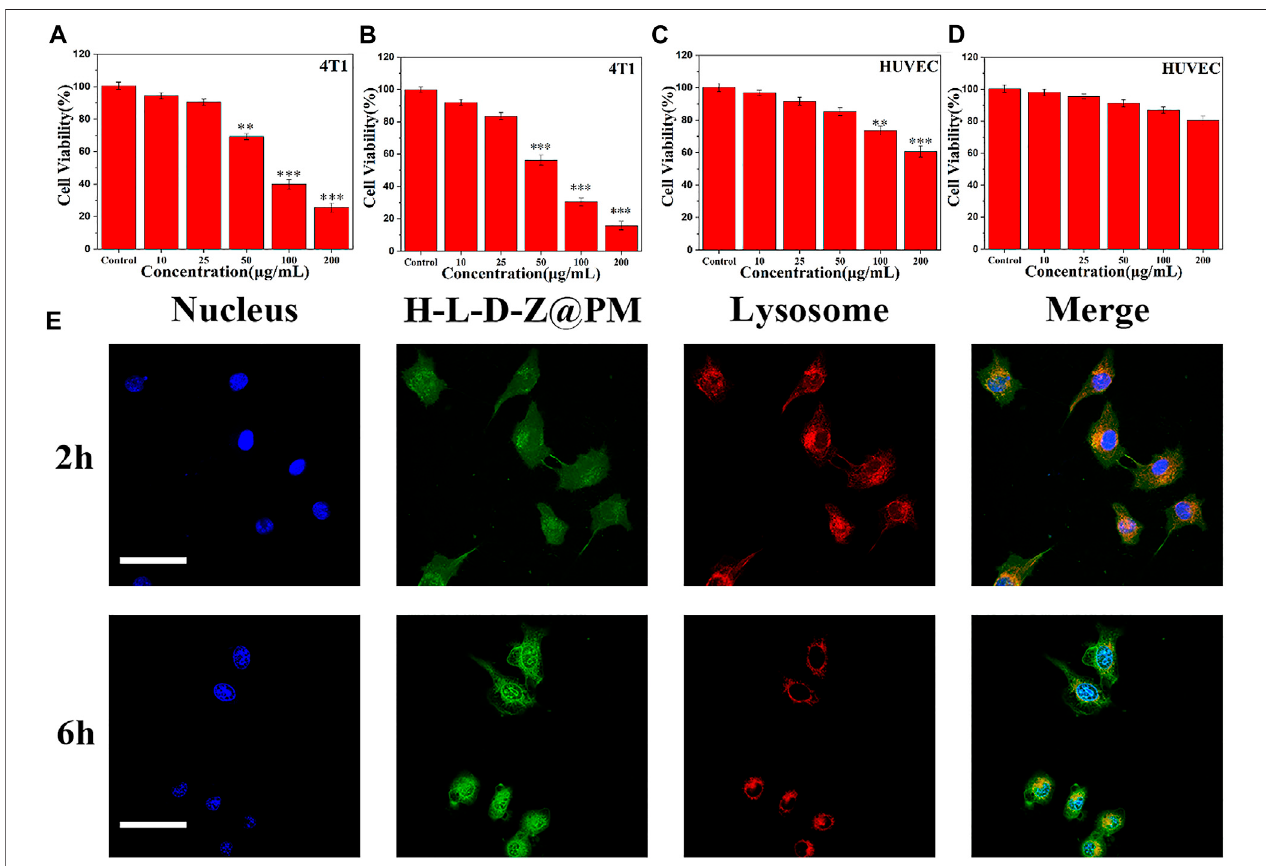
FIGURE 3 | Cell viability of 4T1 cells treated with (A) H-L-D-Z NPs and (B) H-L-D-Z@PM NPs within 24 h. In vitro viability of HUVECs incubated with (C) H-L-D-Z NPs and (D) H-L-D-Z@PM NPs for 24 h. (E) Endocytosis of H-L-D-Z@PM NPs. Scale bars: 10 μ m ** p < 0.01, *** p < 0.001.